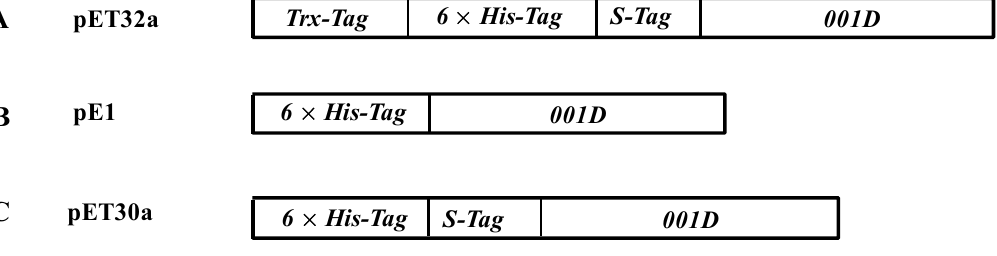
Figure 6. Gene maps of fusion recombinant plasmids harboring truncated ( A ) Trx/6×His/S-tag/001D from pET32a; ( B ) 6×His-tag/001D from pE1; and ( C ) 6×His/S-tag/001D from pET30a. For protein expression, a colony from freshly transformed E. coli was used to inoculate 5 mL of Luria-Bertani (LB) broth medium containing 50 μ g·mL − 1 kanamycin. Cells were cultured overnight